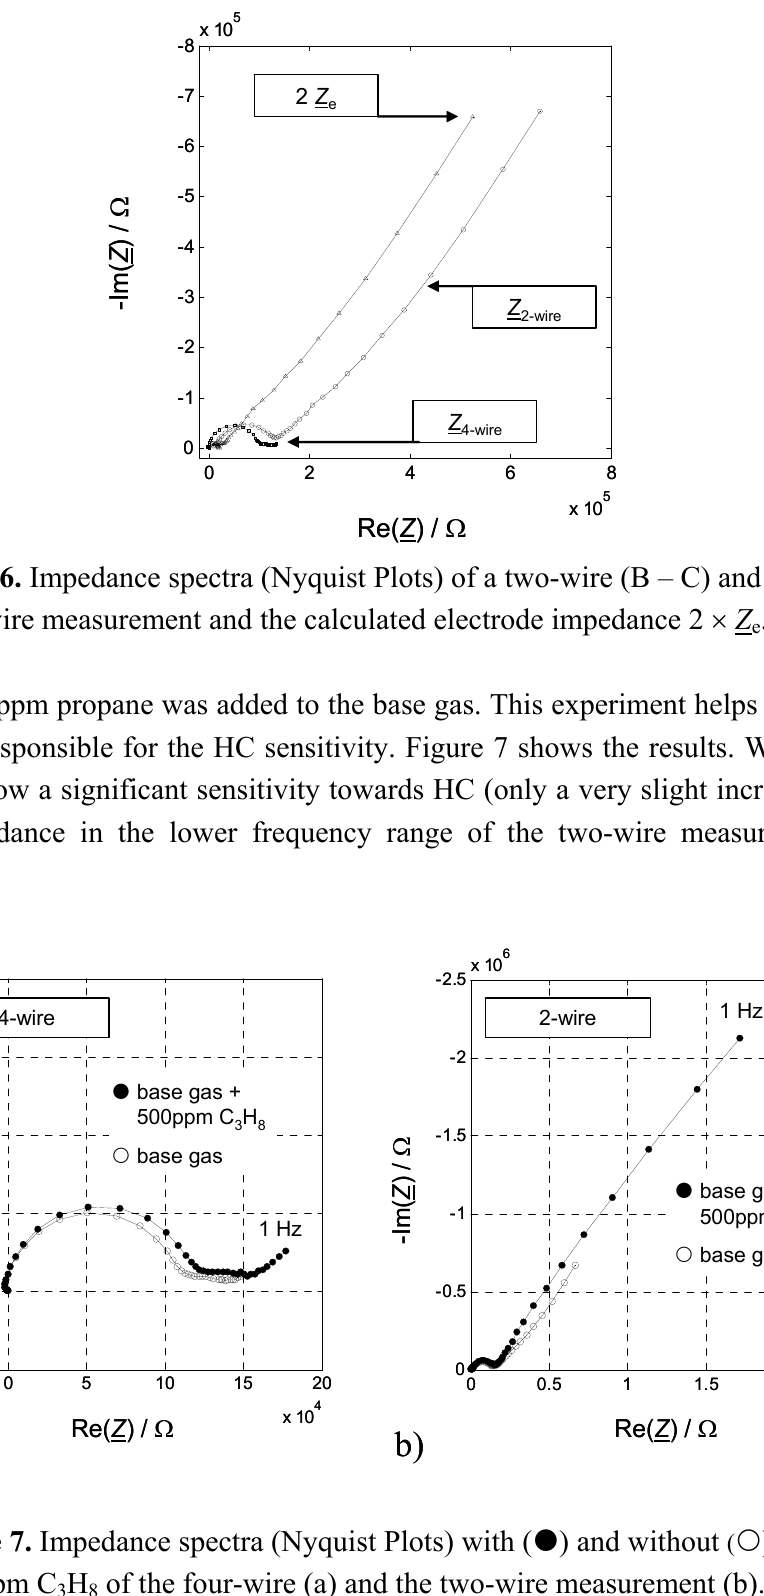
Figure 7. Impedance spectra (Nyquist Plots) with ( (cid:122) ) and without ( (cid:123) ) H of the four-wire (a) and the two-wire measurement 500 ppm C 3 8